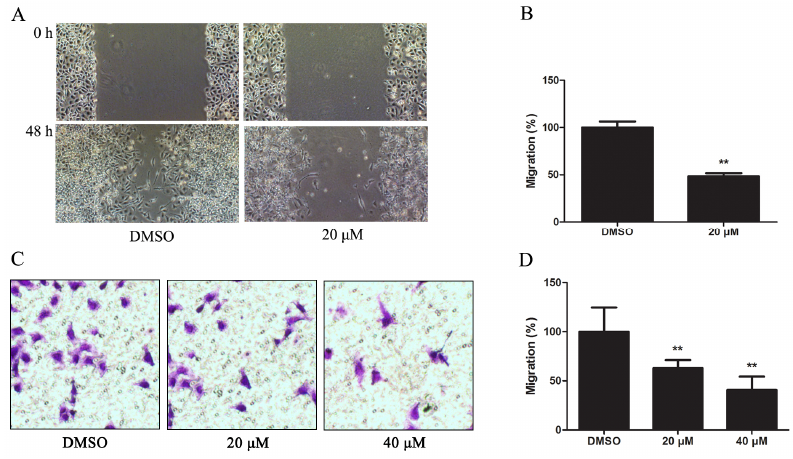
Figure 3. Kae suppresses migration of EJ cells. ( A ) Wound-healing assay in EJ cells treated with DMSO or 20 μ M Kae for 48 h; ( B ) Migrated cells in wound-healing assay were counted under a microscope at ×200. Data from three independent experiments were analyzed and presented as the mean ± SD ( ** p < 0.01 vs . DMSO-only group); ( C ) Transwell cell migration assay in EJ cells with DMSO-only or 20 or 40 μ M Kae for 48 h; ( D ) Migrated cells on the lower chamber membrane were counted. Data from three independent experiments were analyzed and presented as the mean ± SD. ** p < 0.01 vs . DMSO-only